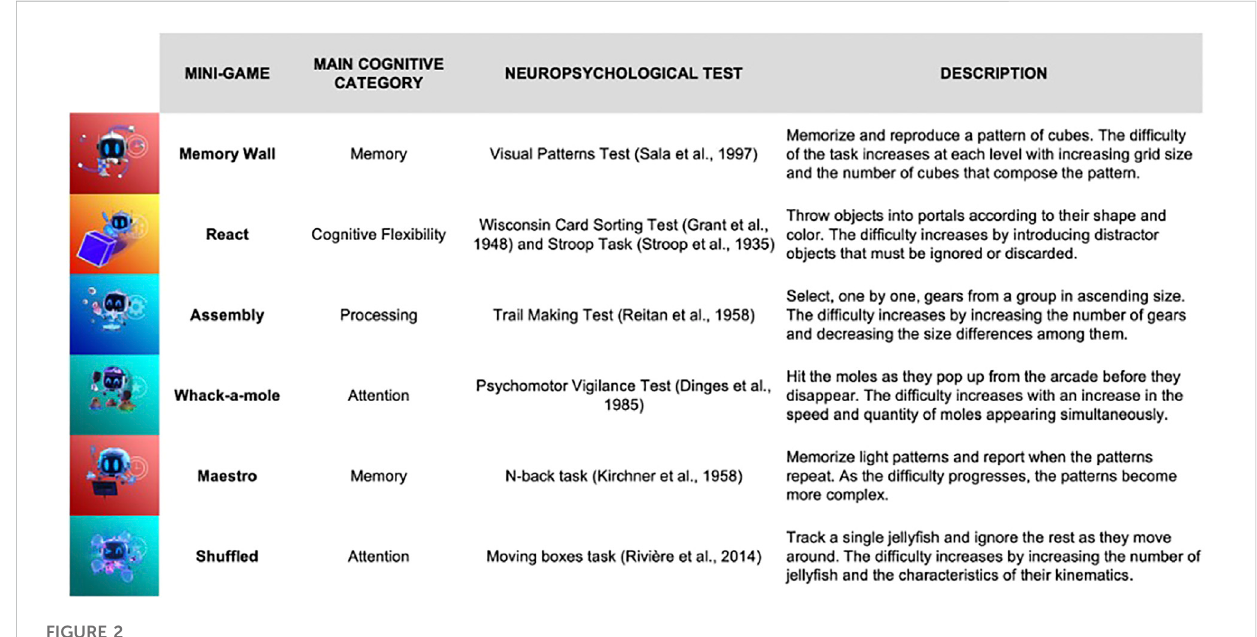
FIGURE 2 Enhance VR games used in